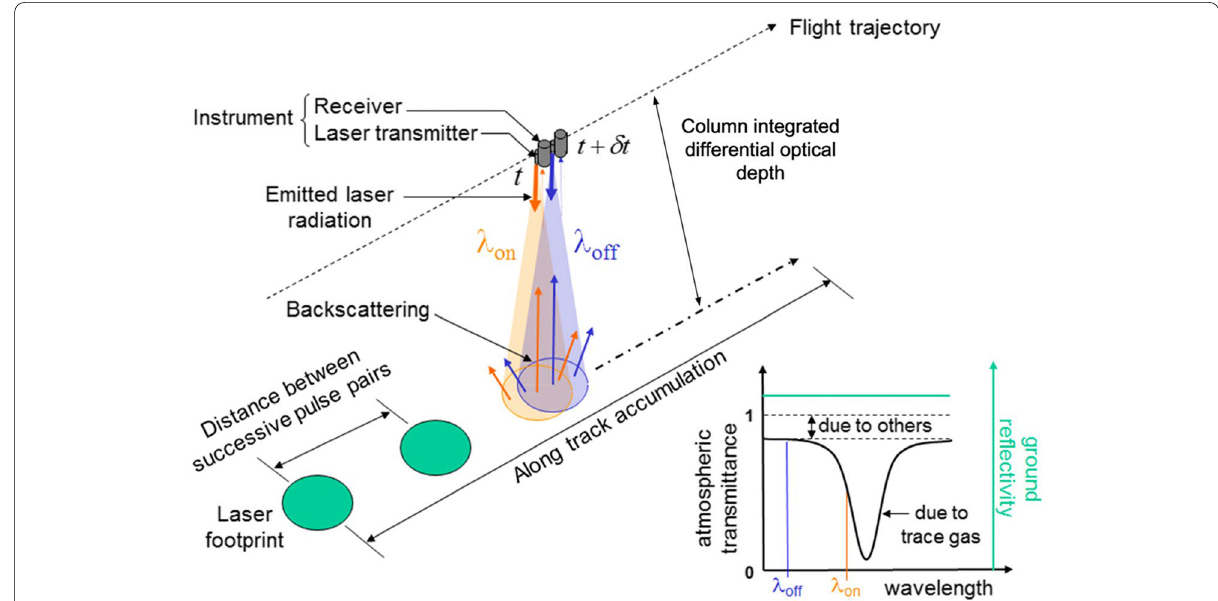
Fig. 7 The sounding diagram of atmospheric concentration sounding